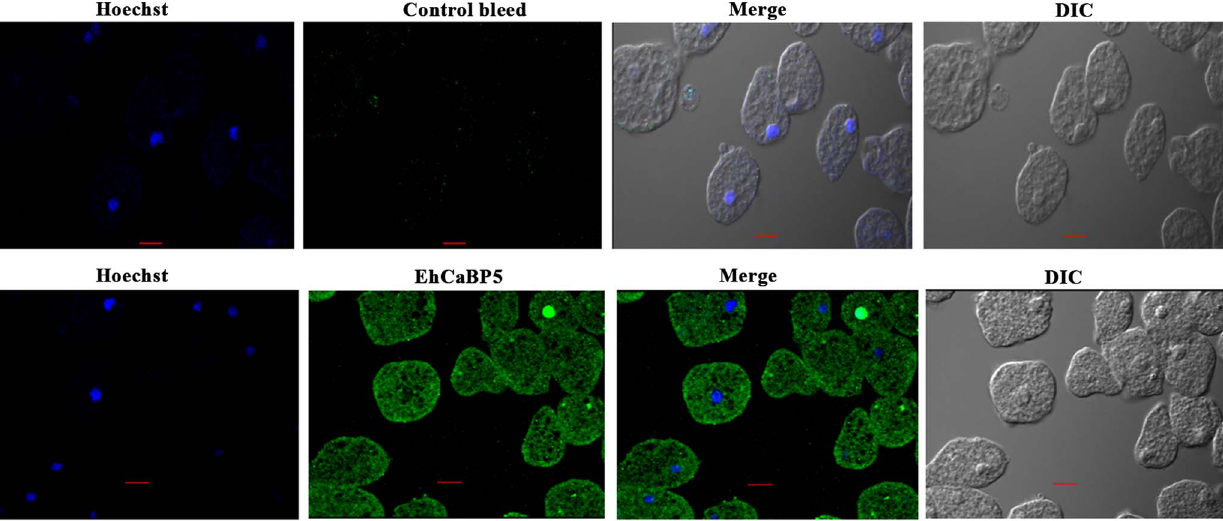
Fig 5. Immunolocalization of EhCaBP5 in E.histolytica . Trophozoites grown for 48 h were transferred to pre-warmed coverslips for 10 min at 37 u C. The cells were then fixed with 3.7% paraformaldehde/PBS, permeabilized with 0.1% triton X-100/PBS and then stained with anti-EhCaBP5 antibody followed by secondary antibody Alexa 488. Hoechst was used to stain the nuclei. Bar represents 10 m m. Magnification 60X.